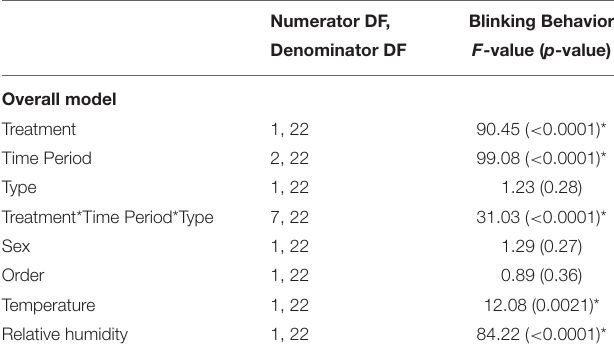
TABLE 1 | The effect of treatment, time period, type, and their interaction as well as sex, order, temperature, and humidity on blinking behavior (composite factor including blink rate, blink duration, and percentage of time spent